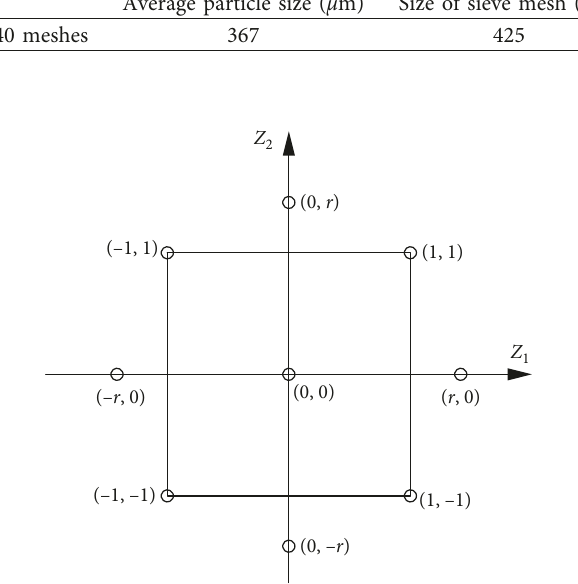
Figure 1: Distribution of test points in the factor space in two- factor combination experiment.